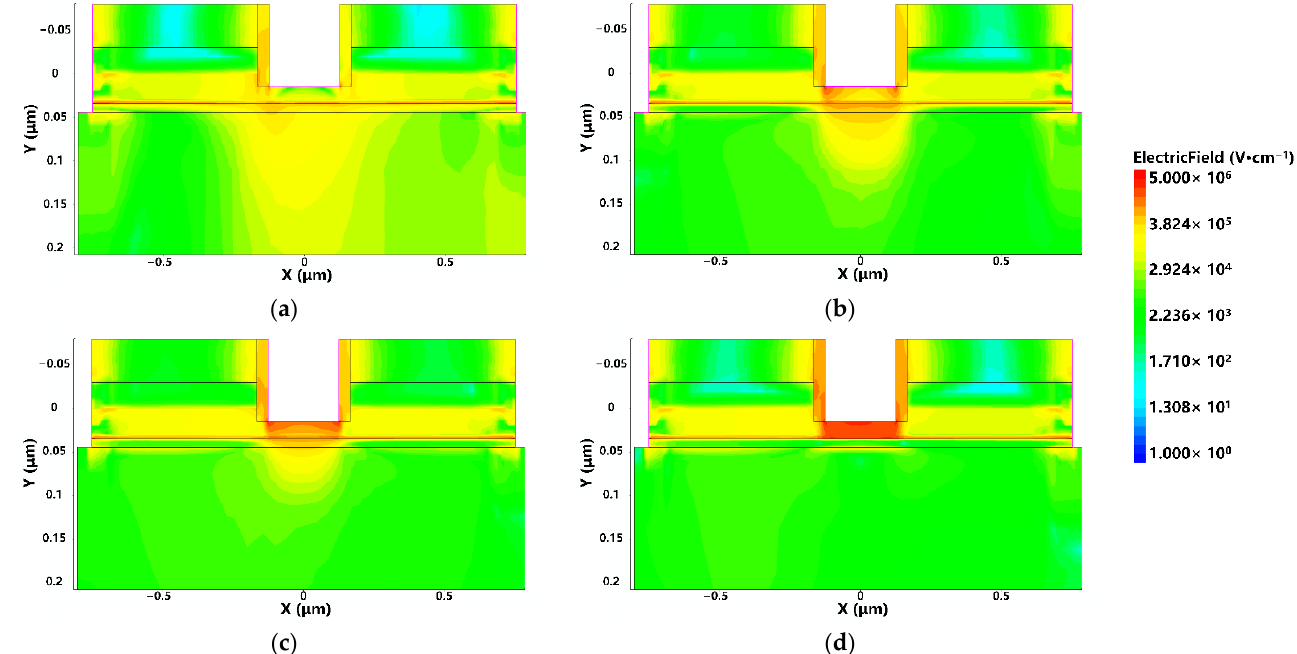
Figure 6. The distributions of electric field strength: ( a ) 0.7 ns; ( b ) 1.0 ns; ( c ) 1.2 ns; ( d ) 1.4 ns.